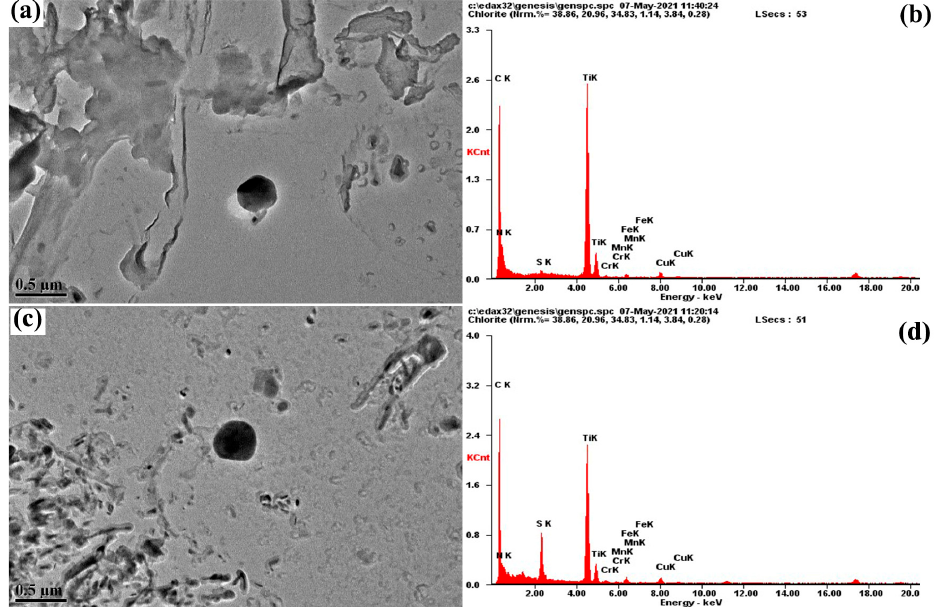
Figure 7. Large size precipitates of test steel at di ff erent coiling temperatures: ( a ) 650 °C; ( c ) 600 °C; ( b , d ) energy spectrum corresponding to precipitates.